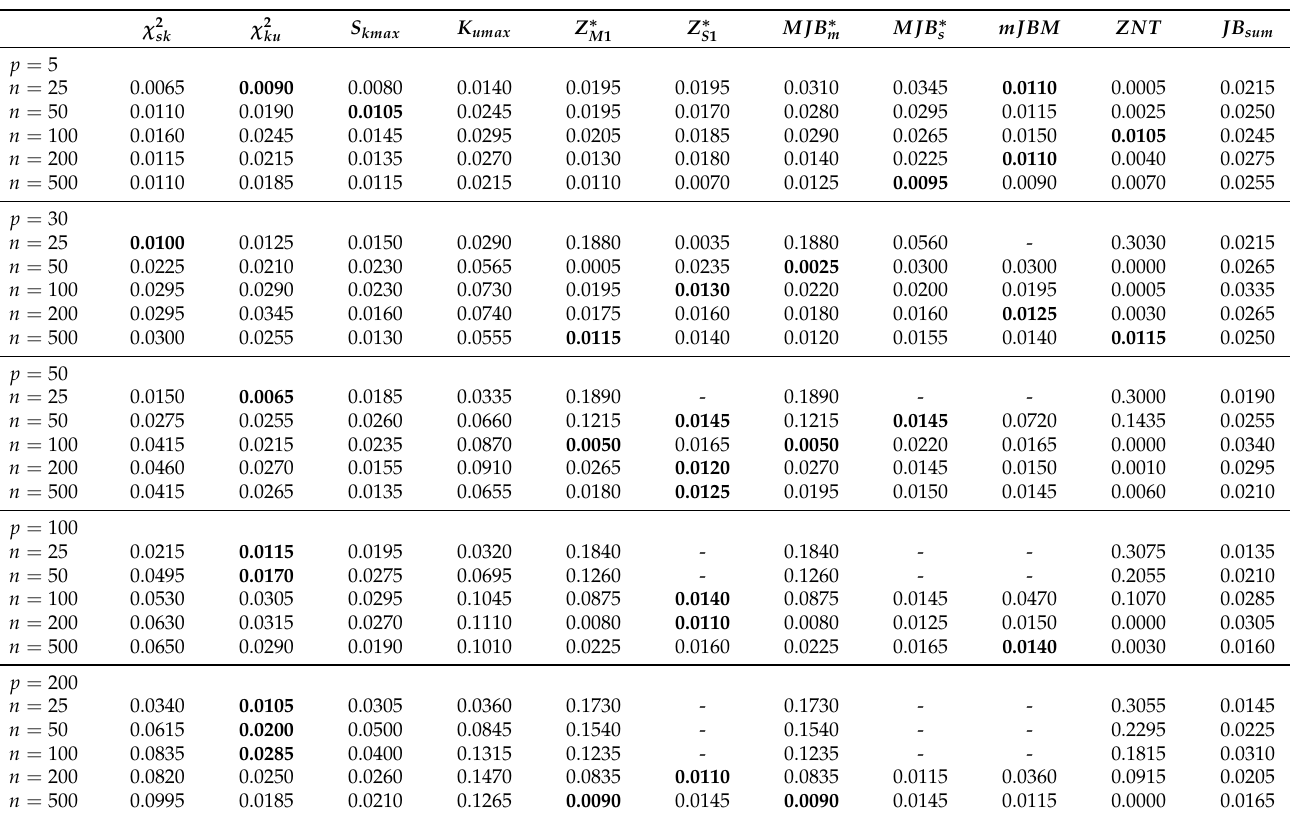
Table 1. Empirical power of PC-type Jarque–Bera (JB) testing for normally distributed data for Case-I compared with other methods ( α =